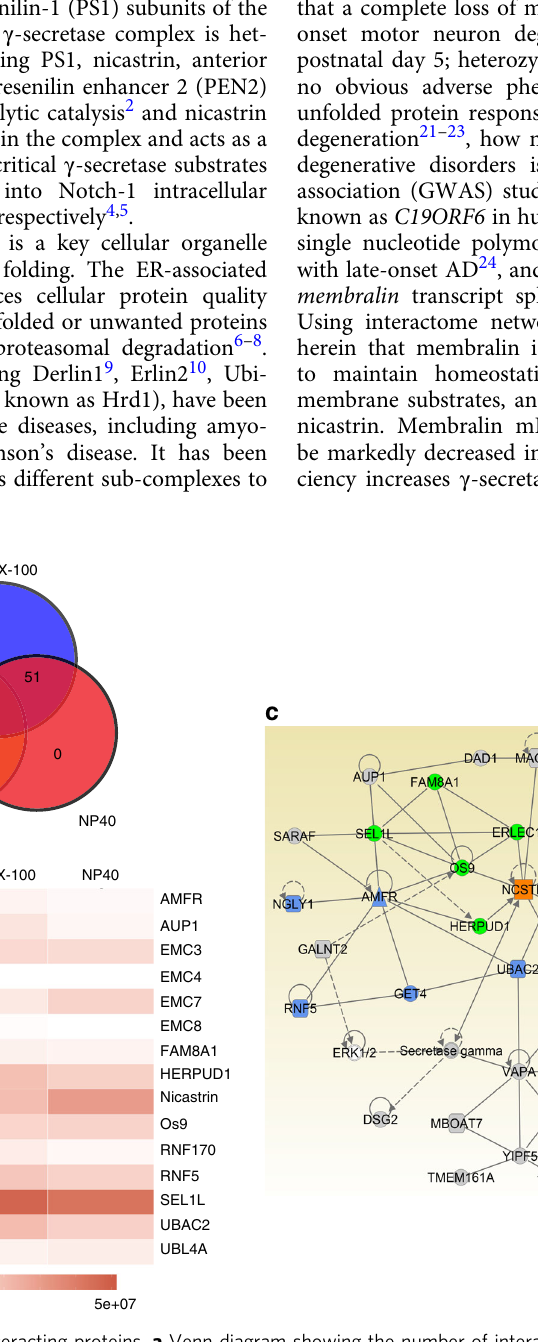
Fig. 1 Proteomic analysis of membralin-interacting proteins. a Venn diagram showing the number of interacting proteins identi fi ed from cell lysates prepared in NP40 ( red ), Digitonin ( yellow ), and TritonX-100 ( blue ). b Among 180 proteins identi fi ed in the membralin interactome (see Supplementary Fig. 1), a heatmap of 14 known ERAD components is presented. The color intensity represents protein intensity (summed peptide area under the curve) ( c ) Interaction network of the membralin interactome by IPA. Three main ERAD subnetworks were highlighted in green (SYVN1 subnetwork), blue (AMFR subnetwork) and yellow (EMC subnetwork). Nicastrin was highlighted in orange color. Solid and dashed lines represent direct interactions and indirect interactions,